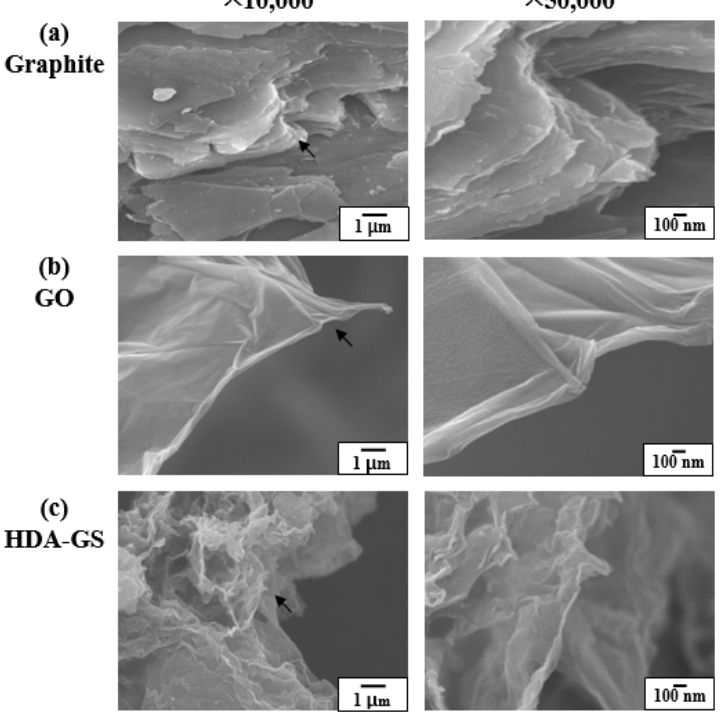
Figure 2. FE-SEM photographs of ( a ) graphite, ( b ) GO, and ( c ) HDA-GS at different magnifications ( × 10,000 and × 50,000).